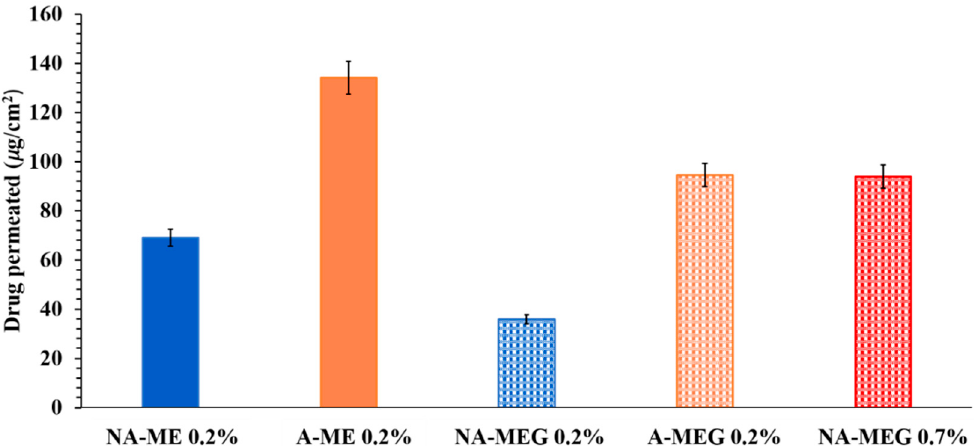
Figure 6. Amount of drug permeated across rabbit ear skin from different samples after 7 h at 37 °C. Values represent means ± S.D. ( n = 3).